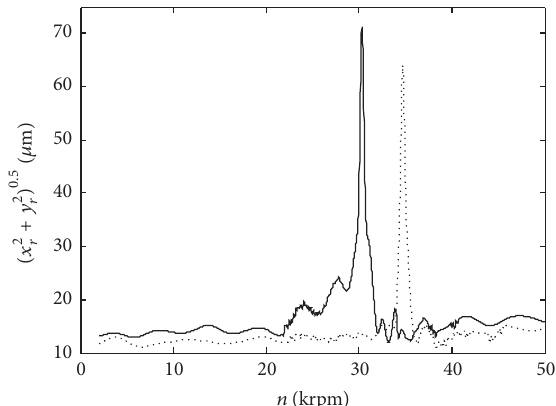
Figure 6: Experimental vibration displacement curve of the front end of spindle in 𝑦 -direction. Figure 7: Theoretical radial vibration displacement curves of the rotor